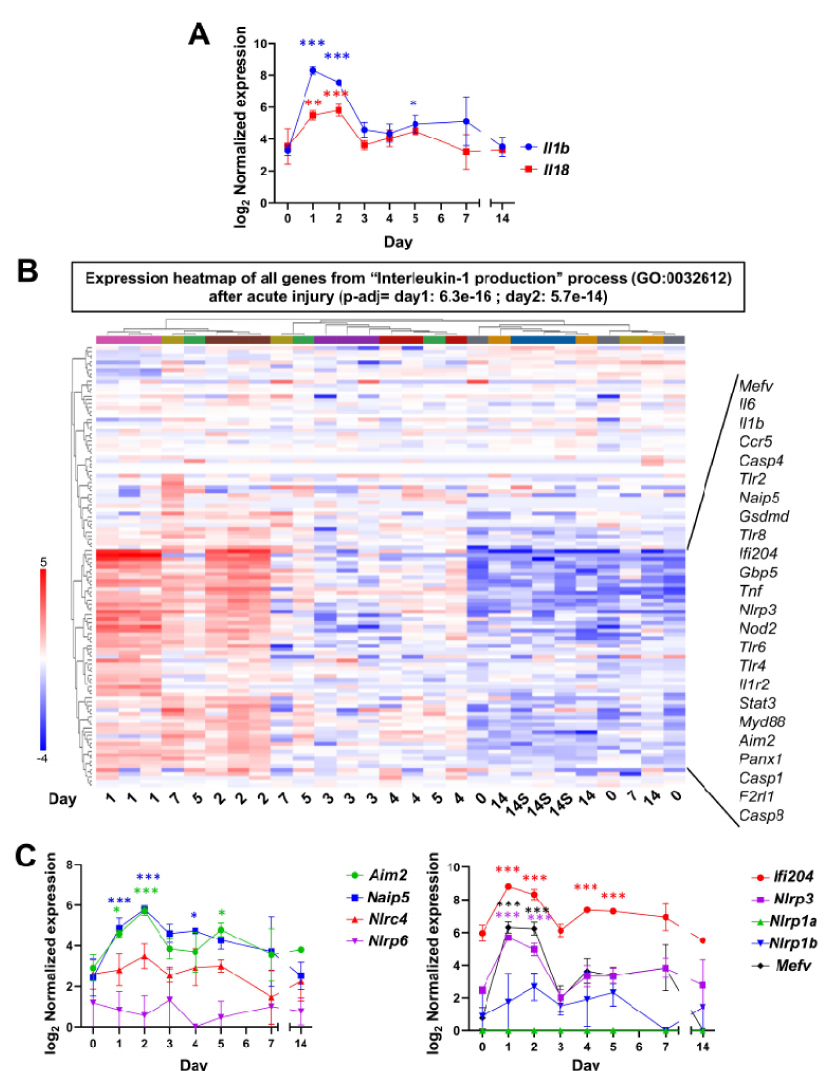
Figure 3. RNA-seq analysis of inflammasome pathway after IL-1 α -induced acute LG injury. After IL-1 α injection into the LG on day 0, ( A ) Il1b and Il18 transcripts were upregulated on days 1 and 2 by RNA-seq. ( B ) Expression heatmap of the genes involved in the pathway entitled “interleukin-1 production” (GO:0032612) show that individual LG samples cluster in 3 main groups, with biological replicates from days 1 and 2 after injury, present an important activation of a set of genes involved in this pathway. Samples from days 3, 4 and 5 show an intermediate profile, while samples from days 14 (IL1- α -injected) and 14S (saline-injected) are similar to uninjected controls (day 0). Genes displayed in the frame to the right were selected from the cluster of upregulated genes as closely associated with inflammasome complexes or as main triggers for their transcription. ( C ) mRNA expression of the different inflammasome sensors in the LGs after injury with IL-1 α . Error bars show the mean (SD). Significant differences are represented as * if p value p < 0.05, ** if p < 0.01, and *** if p < 0.001 and colored as the corresponding